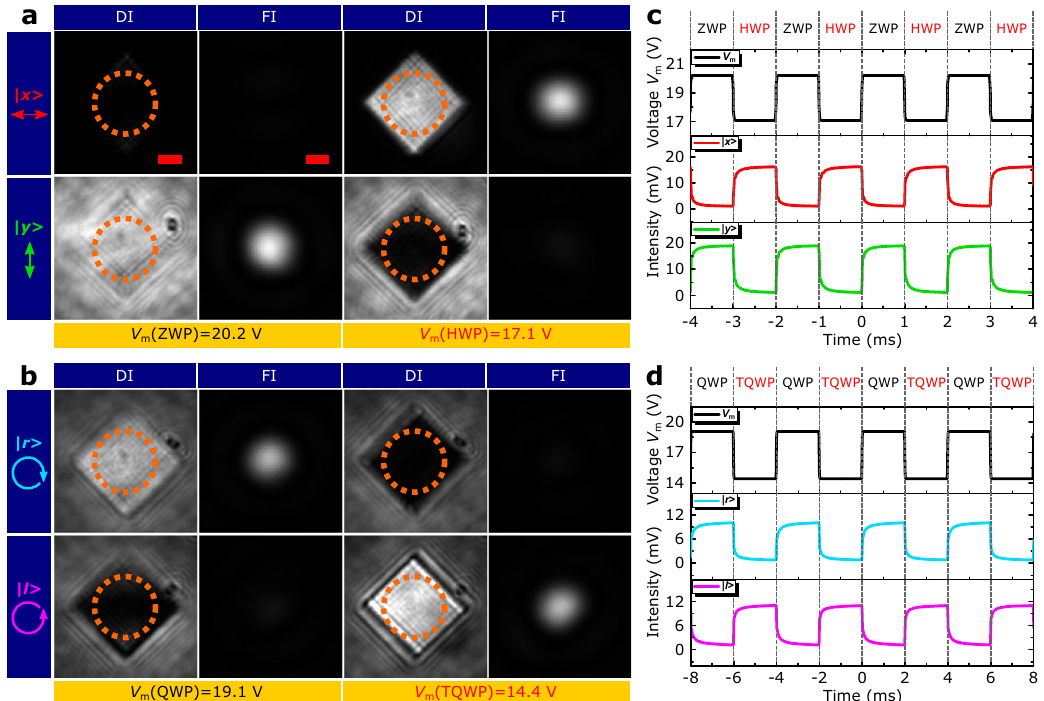
Fig. 3 Polarization conversion dynamics. a , b Optical images of the re fl ected light at the direct image (DI) and Fourier image (FI) planes for the fi xed input linear polarization (LP) state | y > ( θ LP = 90°) and dynamic wave plate (DWP) orientation ( θ DWP = 45°) at λ = 800 nm, showing polarization modulation between orthogonal ( a ) LP states (| x >, | y >), corresponding to zero-wave plate (ZWP)/half-wave plate (HWP) transformation, by changing the actuation voltage V m from 20.2 to 17.1 V, and ( b ) circular polarization (CP) states (| r >, | l >), corresponding to quarter-wave plate (QWP)/three-quarters-wave plate (TQWP) transformation, by changing the actuation voltage V m from 19.1 to 14.4 V. For the FIs, the light is fi ltered using an iris letting through only light re fl ected from inside the orange dashed circles (shown in DIs). The leftmost column in ( a , b ) indicates the polarizer orientations used for fi ltering the respective polarization states in the re fl ected light. Scale bars in the DIs and FIs are 10 μ m and 0.02 k 0 , respectively. c , d Temporal evolution of the re fl ected light power for c ZWP/HWP and d QWP/TQWP transformations, measured by actuating the MEMS mirror with a periodic rectangular signal and fi ltering respective polarization